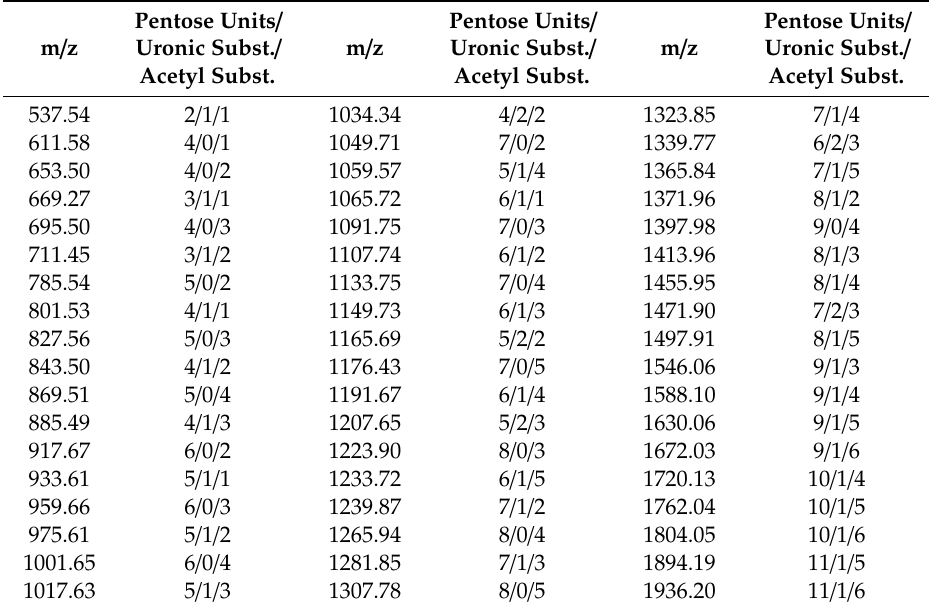
Table 7. Matrix Assisted Laser Desorption / Ionization Time of Flight Mass Spectrometry (MALDI-TOF) data determined for the liquid stream from the third autohydrolysis results (the m / z values corresponded to the sodium adducts of the identified compounds). Pentose Units / Pentose Units / m / z Uronic Subst. / m / z Uronic Subst. / Acetyl Subst. Acetyl